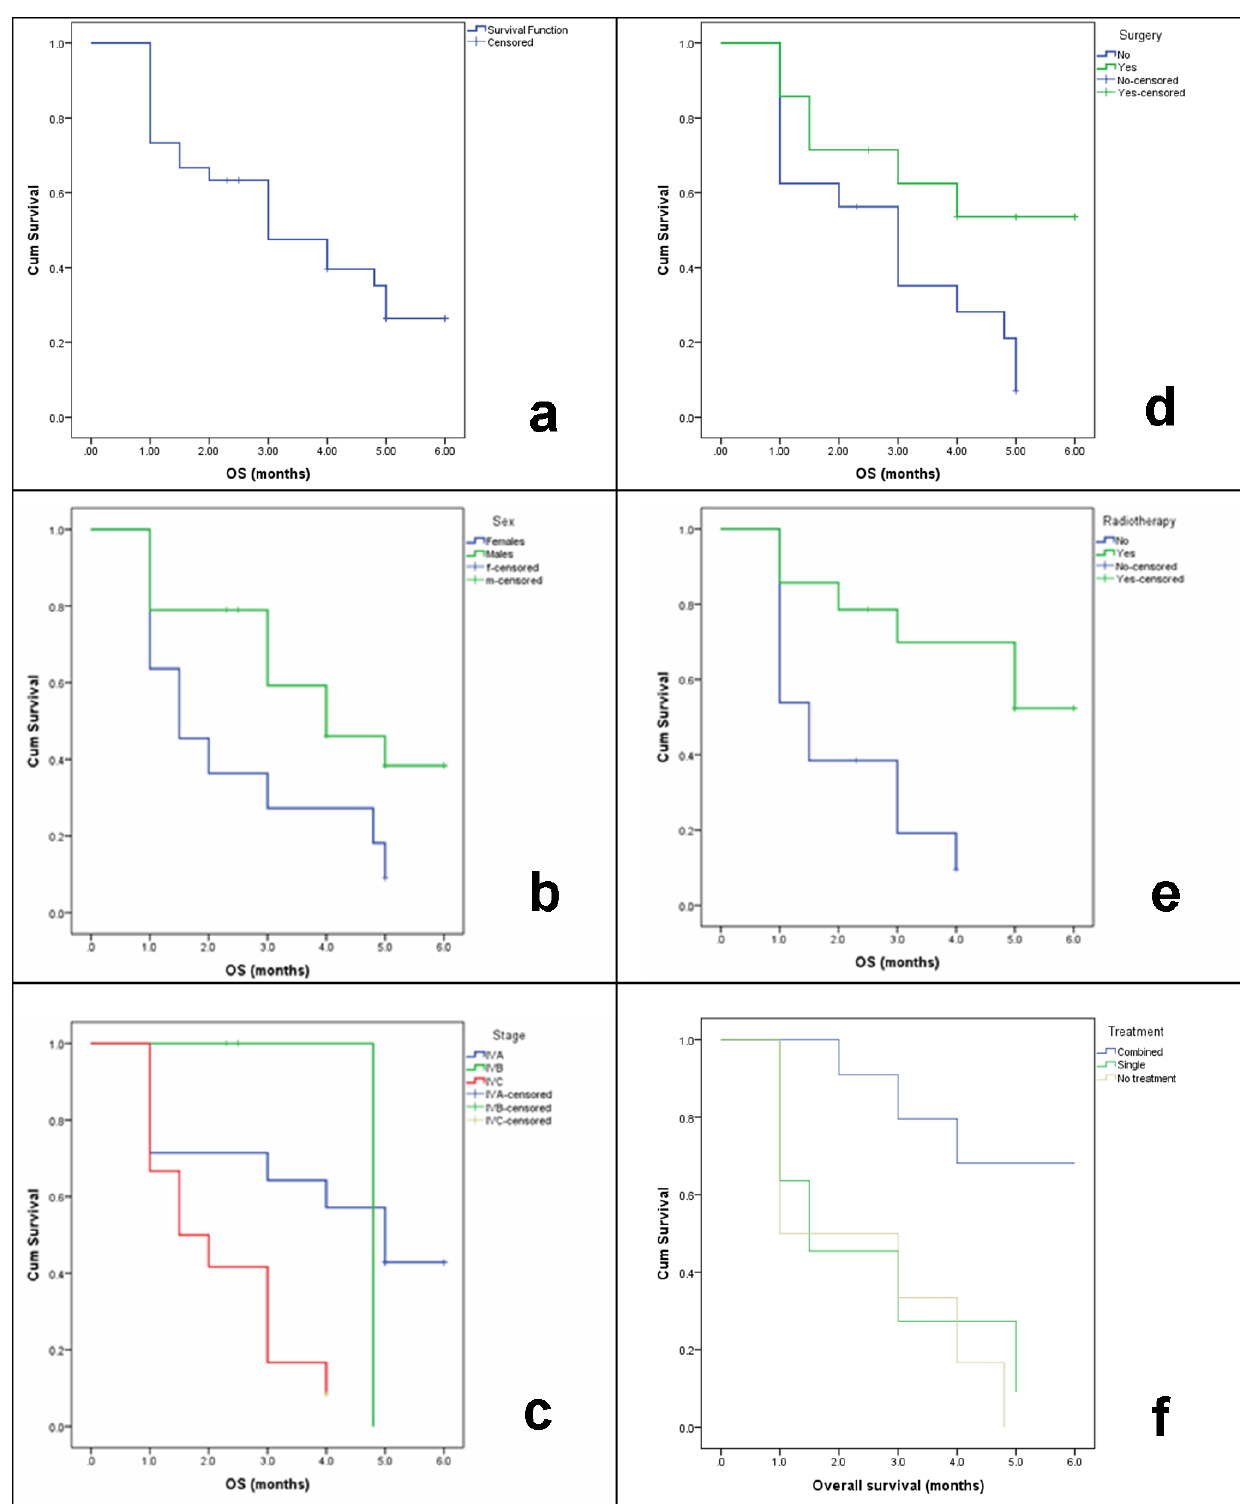
Figure 1: Overall survival according to: a) whole group , b) sex , c) stage d) surgery e) radiotherapy , and f) treatment modality approach (single vs. combined